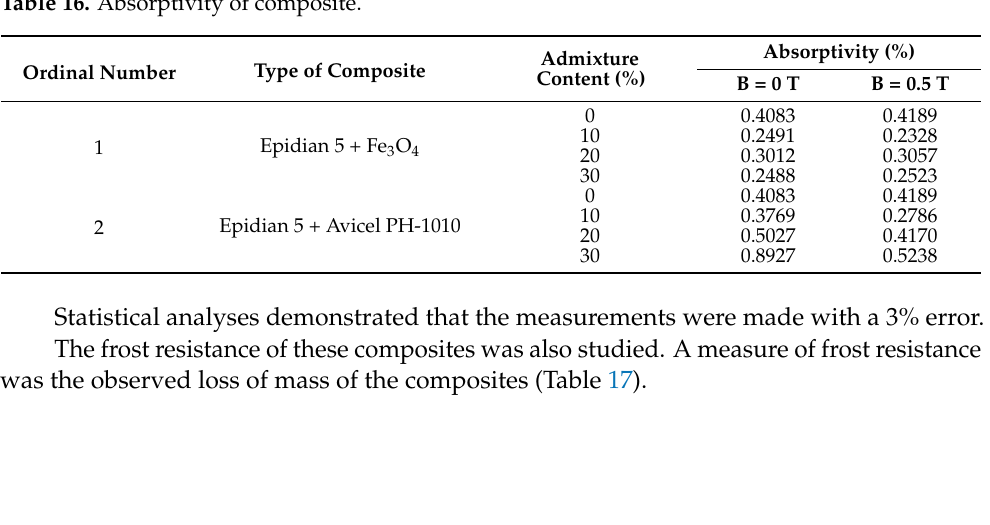
Table 16. Absorptivity of